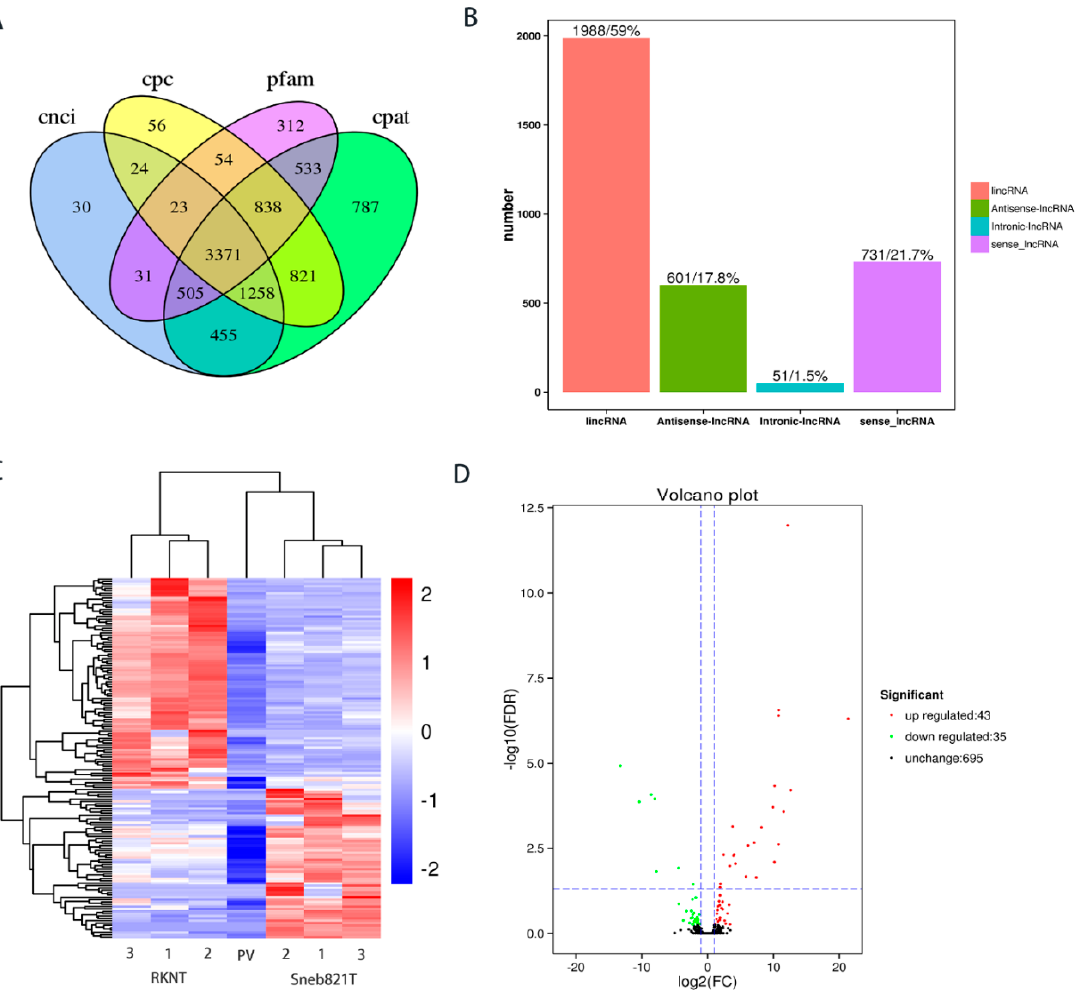
Figure 2. Prediction and difference analysis of novel lncRNA of tomato. ( A ) Venn analysis of the predicted novel lncRNAs from CNCI, CPC, Pfam and CAPT softwares. ( B ) Classification of the predicted novel lncRNAs. ( C ) Heat map in tomato RKNT and Sneb821T. 1, 2, 3 = three independent experiments. PV = p -Value. ( D ) Volcano plot in tomato RKNT and Sneb821T. FC = fold change; FDR = false discovery rate.